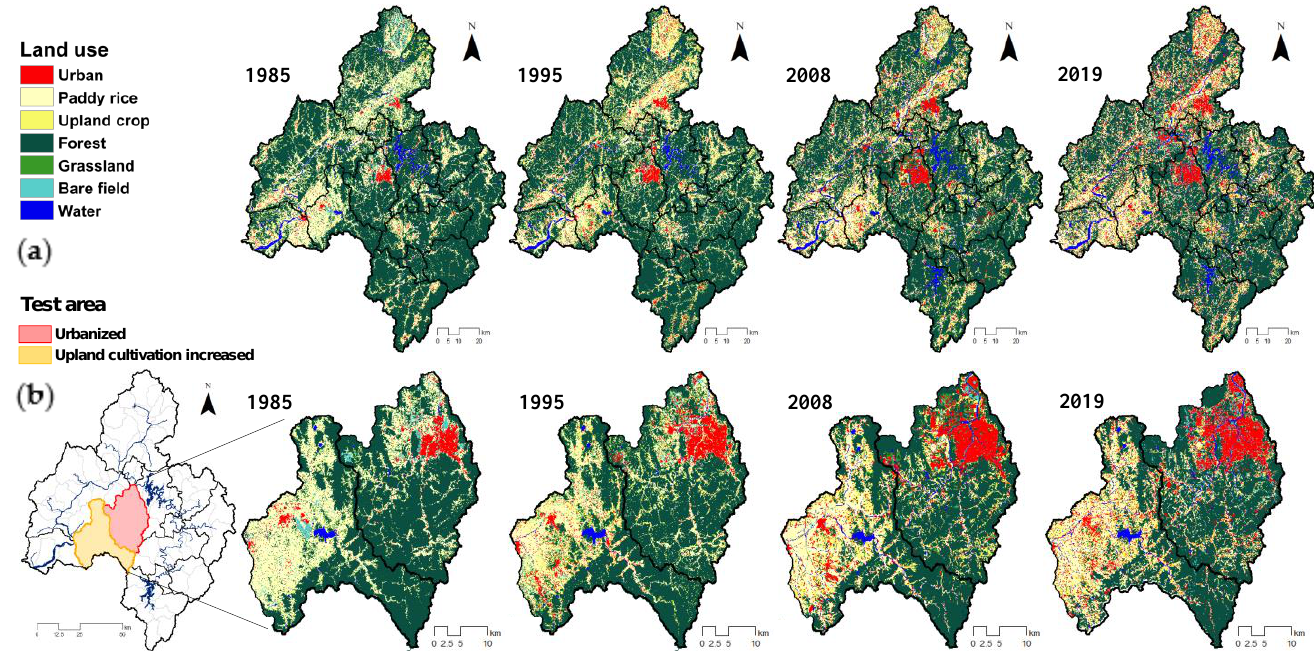
Figure 2. Land-use data of ( a ) Geum River Basin and ( b ) two test subbasins.